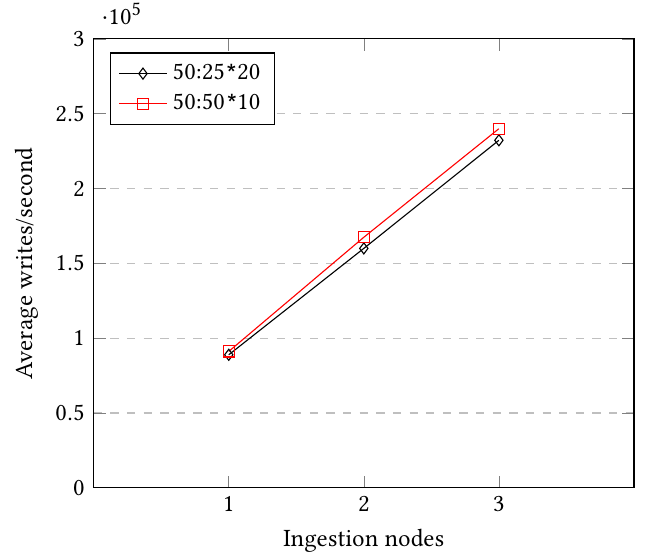
Figure 18. Performance of the different setups for a column length of 50 time Figure 5: Scalability of the proposed approach with one to Figure 4: Scalability of the proposed approach with one to three ingestion nodes, for set ups of 50 as column length. three ingestion nodes, for set ups of 10 as column length.